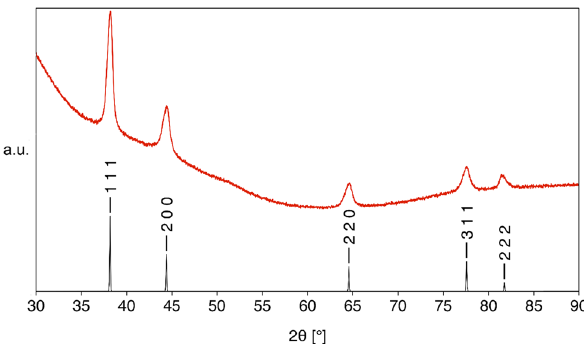
Figure 3: XRD spectrum of unconjugated freeze - dried AuNPs, within a PVP